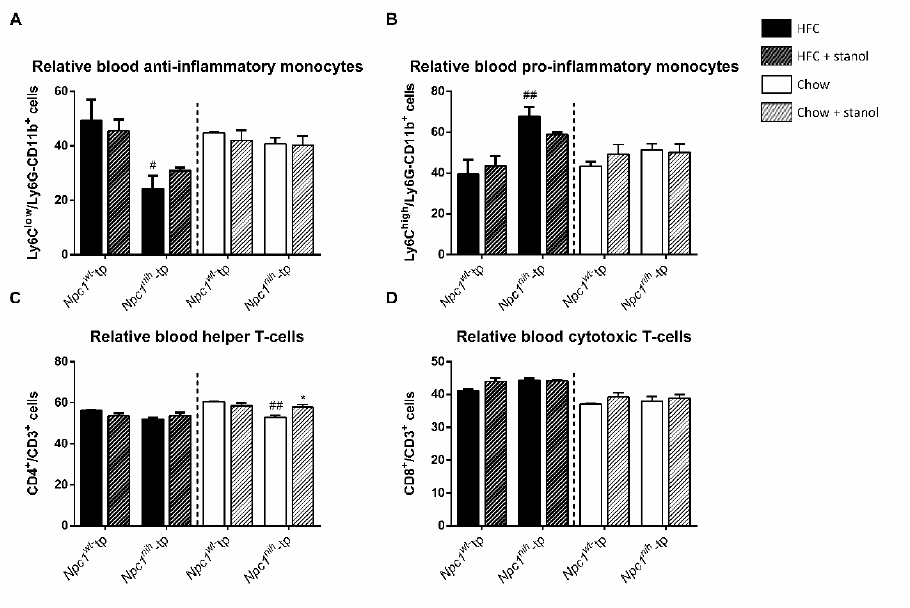
Figure 7. Phenotype and levels of blood monocytes and T-cells: HFC and chow diets . Relative levels of plasma ( A ) pro-inflammatory (LyC6+) and ( B ) anti-inflammatory (LyC6 − ) monocytes, as well as of ( C ) cytotoxic (CD8+) and ( D ) helper T-cells (CD4+) were measured by FACS analysis. n = 4 mice per group. All error bars represent standard error of the mean. Statistical significance is indicated as follows: Npc1 nih -tp mice on a HFC or chow diet vs. Npc1 wt -tp mice on a HFC or chow diet (# p ≤ 0.05; ## p < 0.01); Npc1 wt - tp or Npc1 nih - tp on a HFC or chow diet vs. Npc1 wt -tp or Npc1 nih -tp mice on a plant stanol-enriched HFC or chow diet (* p ≤ 0.05).